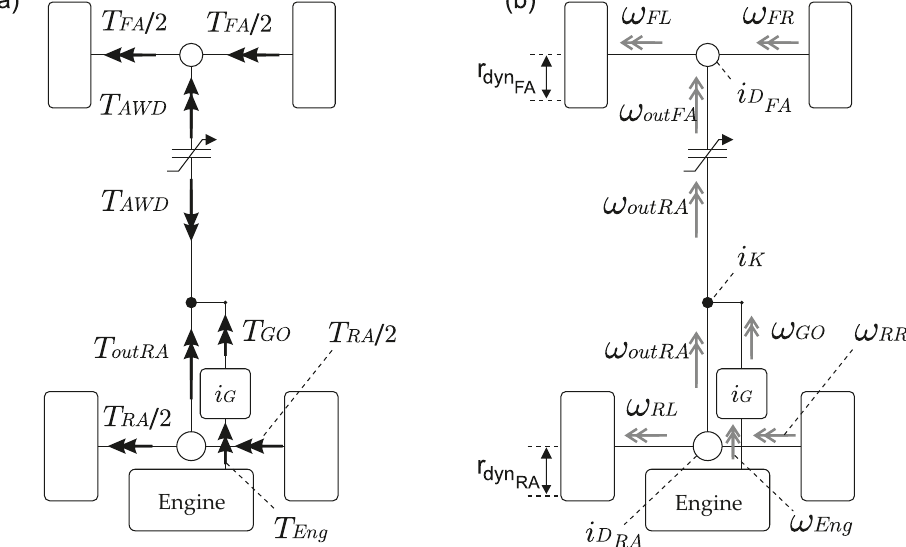
Figure 2. ( a ) Torque and ( b ) rotational speed in the powertrain of an all-wheel-drive vehicle with torque-on-demand transfer case.